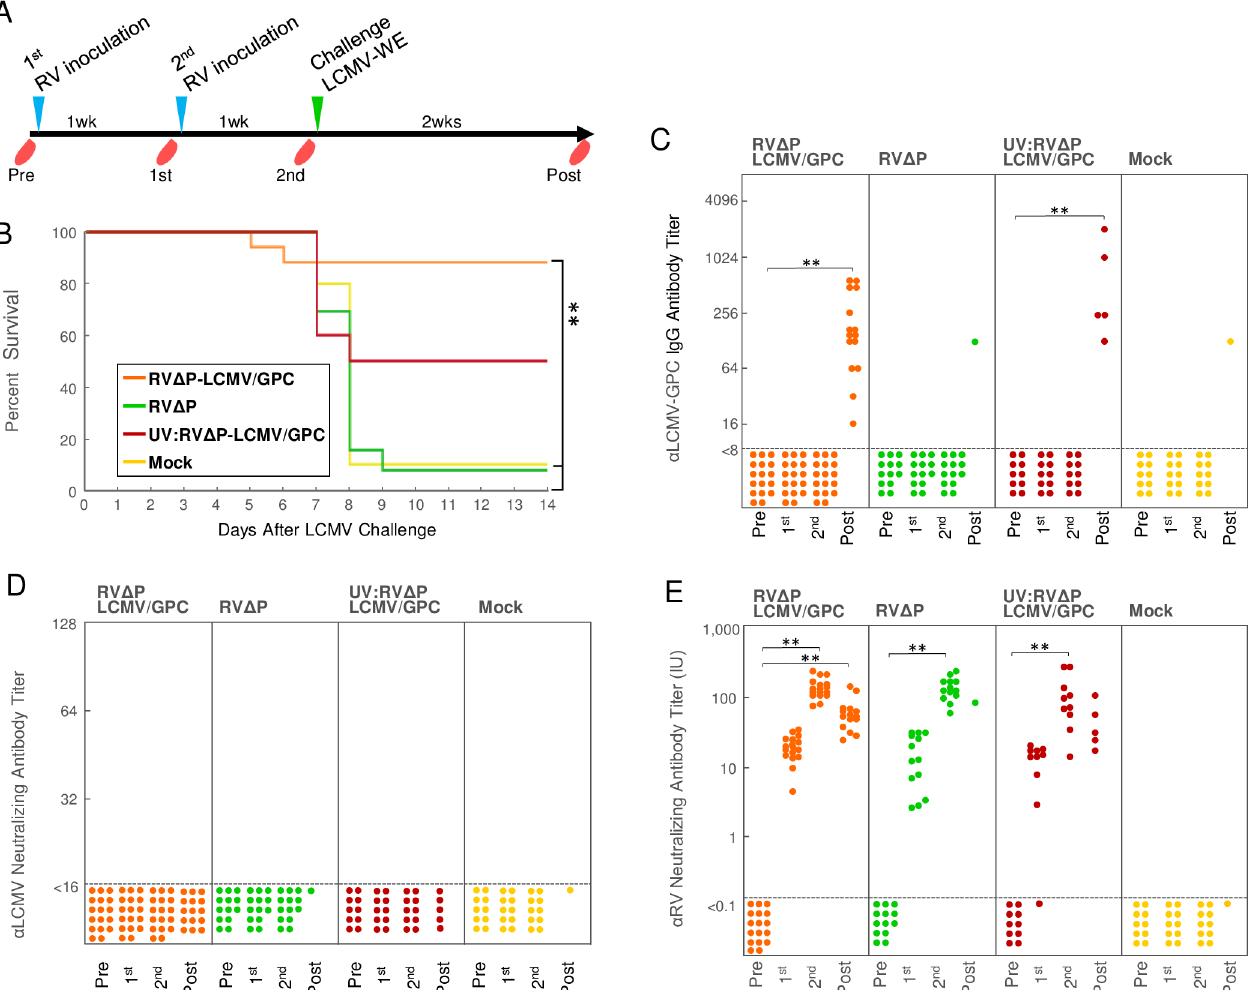
Fig 5. Survival curves and antibody titers in mice inoculated with RV vectors before LCMV-WE infection. (A) RV inoculation, challenge, and blood collection schedules in C57BL/6 mice. Mice were inoculated twice with RV Δ P-LCMV/GPC, RV Δ P,UV-irradiated RV Δ P-LCMV/GPC, or PBS (mock- inoculated control) at 1-week intervals. One week after the last inoculation of RVs, mice were challenged with 10 PFU of LCMV-WE and observed for 2 weeks. Serum was collected from mice inoculated with RVs 1 day before the first RV inoculation (Pre) and second RV inoculation (1st) and at the LCMV challenge (2nd). Serum was collected from surviving mice on the last day of the 2-week observation period (Post). (B) The survival curve of mice inoculated with RV Δ P-LCMV/GPC, RV Δ P, UV-irradiated RV Δ P-LCMV/GPC or PBS. Asterisks indicate a significant difference (p < 0.001). The titers of IgG antibody against the LCMV-GPC (C) and NAb against LCMV (D) and RV (E) in serum of mice inoculated with RV Δ P-LCMV/GPC (n = 17), RV Δ P (n = 13), UV- irradiated RV Δ P-LCMV/GPC (n = 10), or PBS (n =